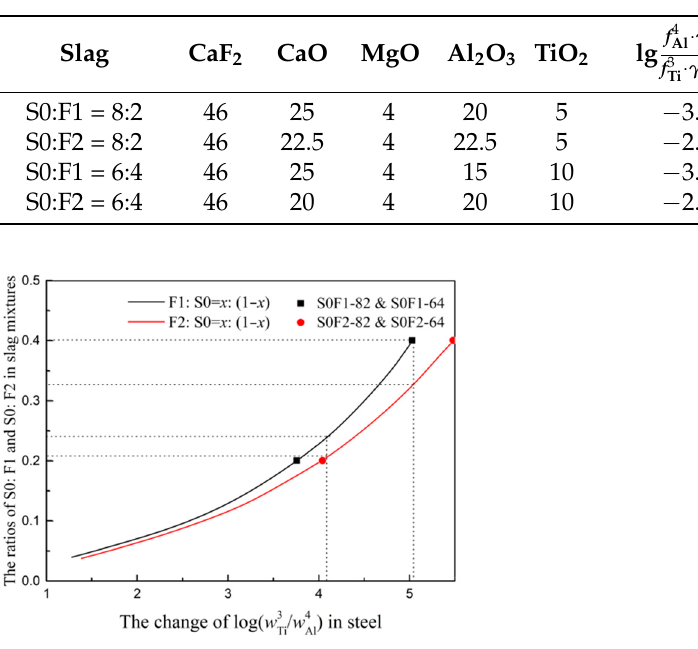
/ w 4 ) in steel. 4 [Al]3 ww ) in steel. [ Al ] [ Ti ] [Ti]